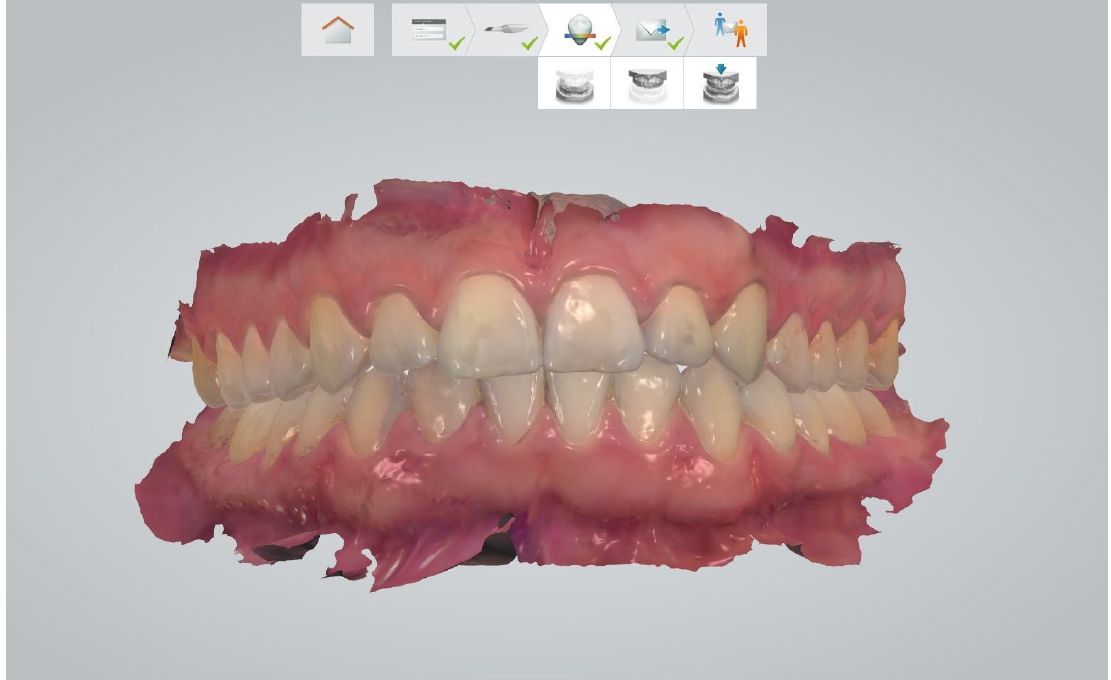
Figure 1. Digital impression of dental arches in occlusion with intraoral scanner. 2. A facial scan was acquired using a hybrid LED and infrared light source